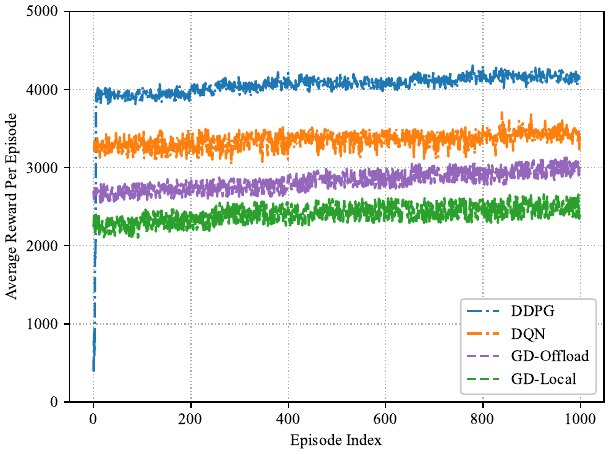
Figure 6. Convergence performance based on different schemes in the training